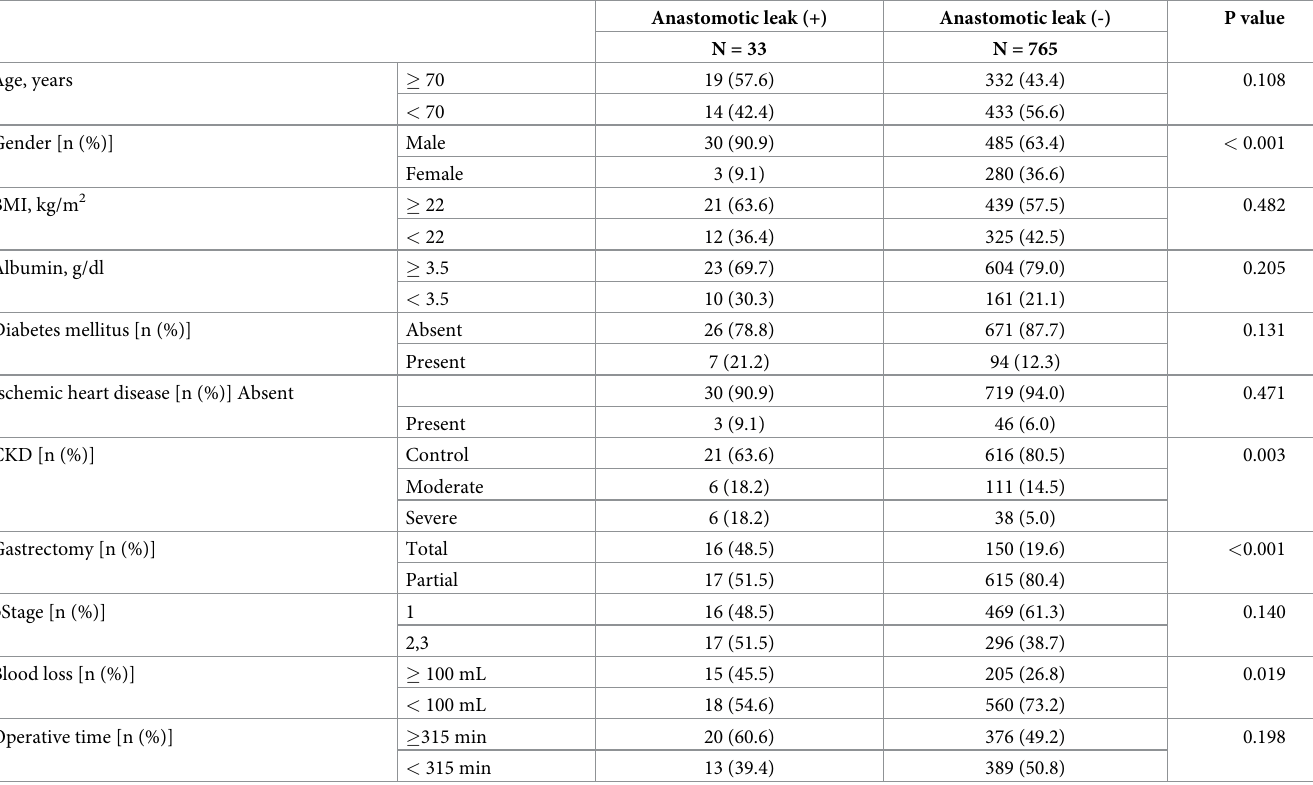
Table 2. Characteristic variables and anastomotic